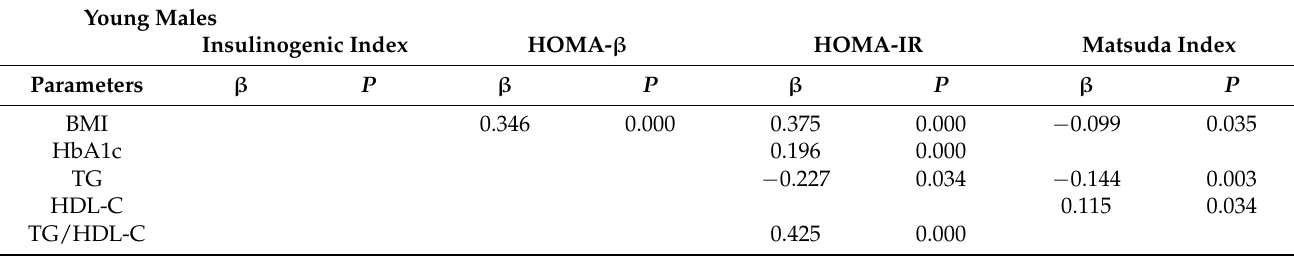
Table 3. Multiple linear regression analysis between insulin release/sensitivity indices and lipid